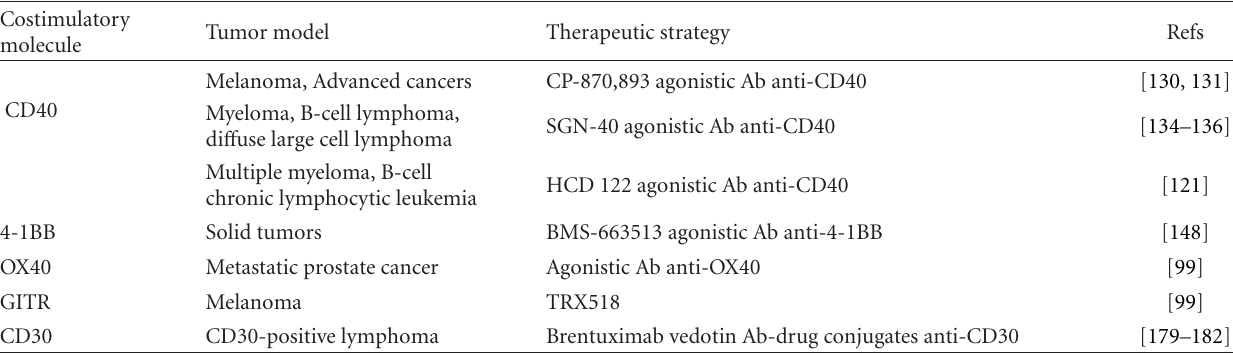
Table 2: Clinical trials of TNF:TNFR costimulatory